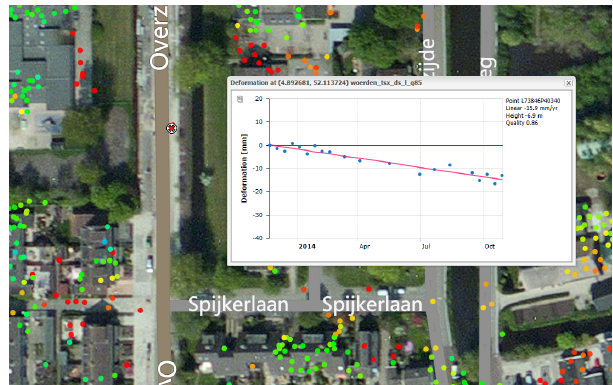
Figure 5. Example of present settlement observations by InSAR